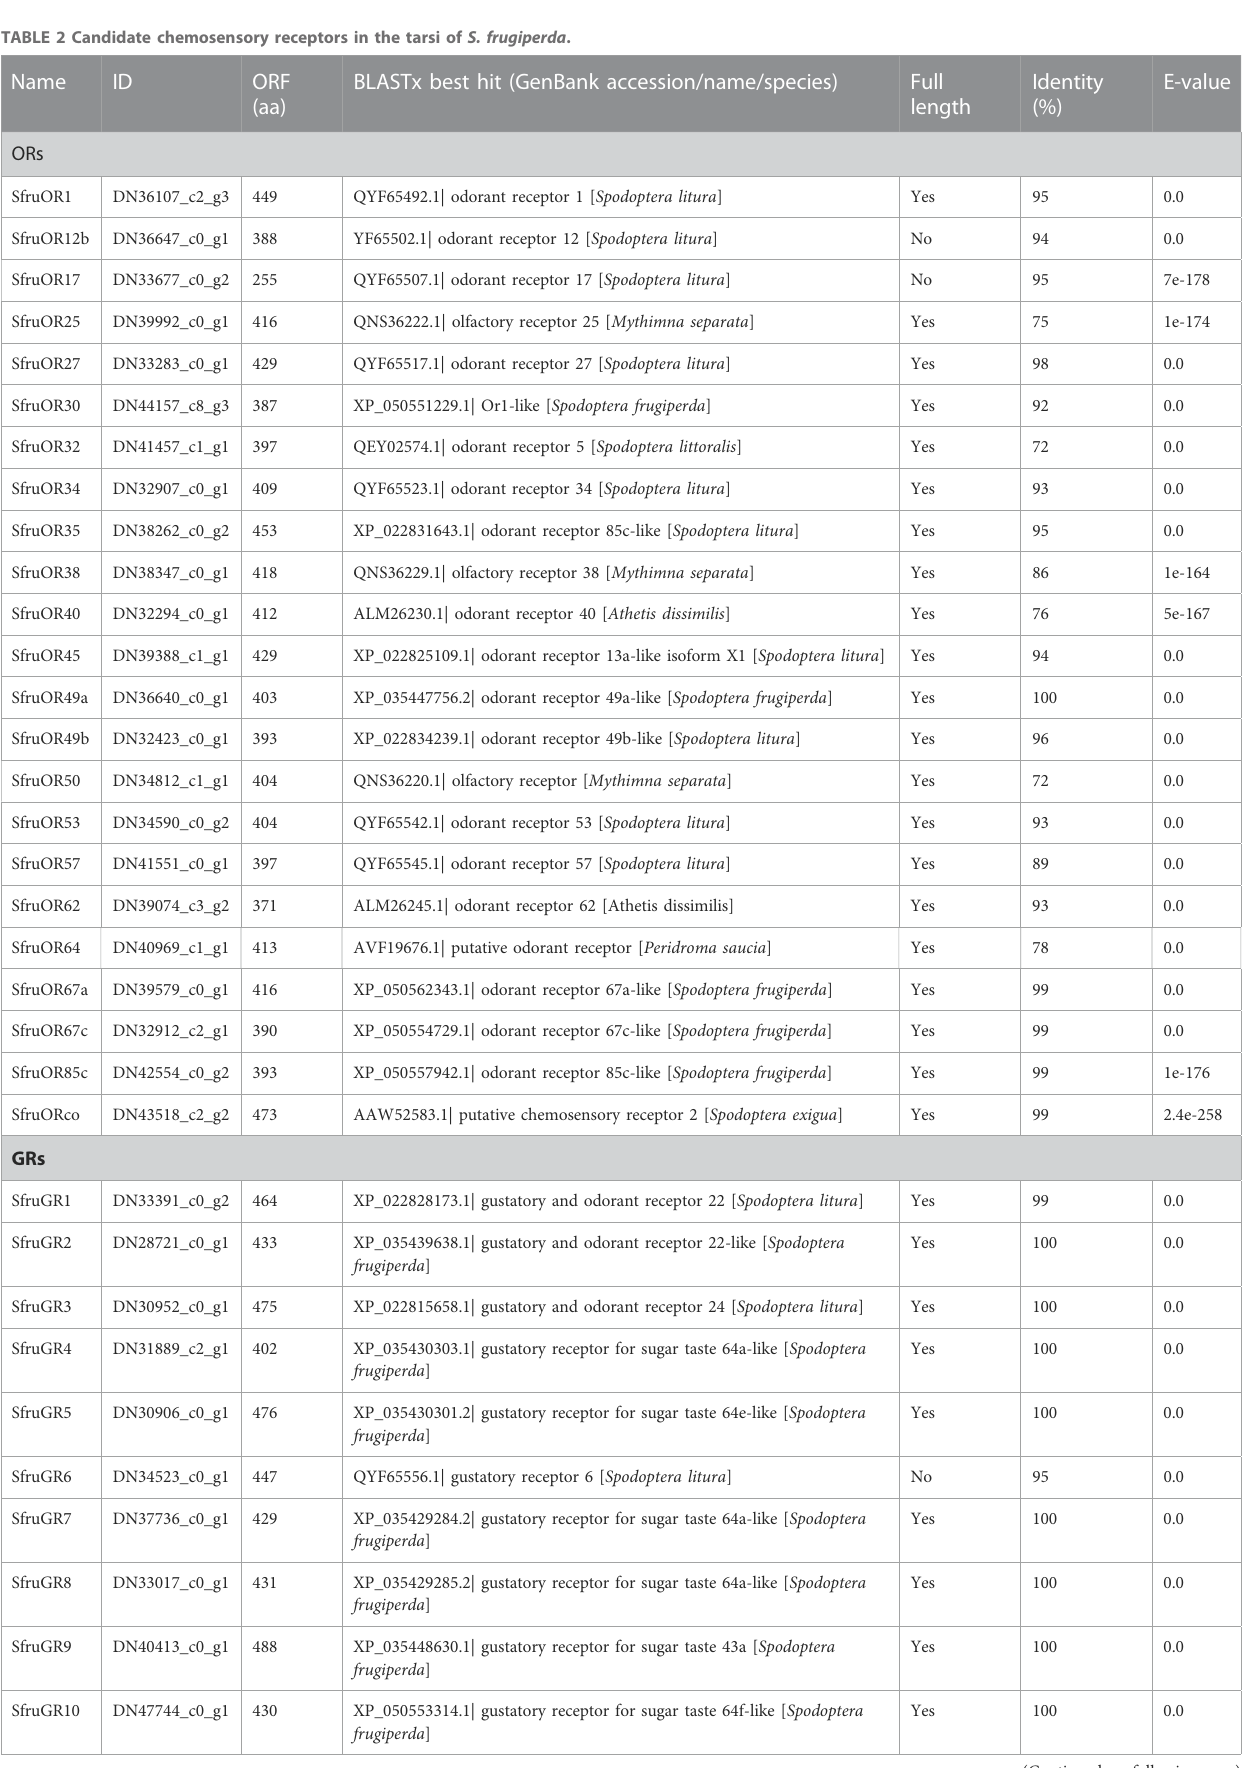
TABLE 2 Candidate chemosensory receptors in the tarsi of S. frugiperda